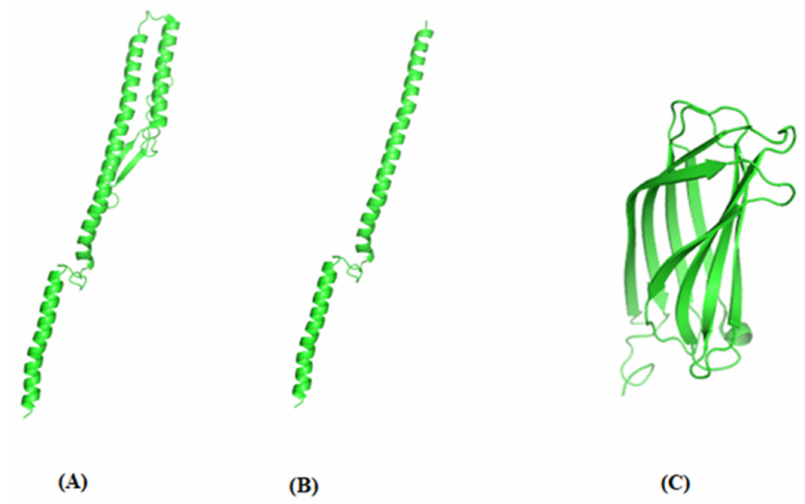
Figure 3. Predicted structure of ( A ) FliC 176 and ( B ) FliC 99 based on PDB ID: 1UCU. ( C ) Predicted structure of t VP2 199–356 based on PDB ID: 2DF7 using PyMOL2.5.